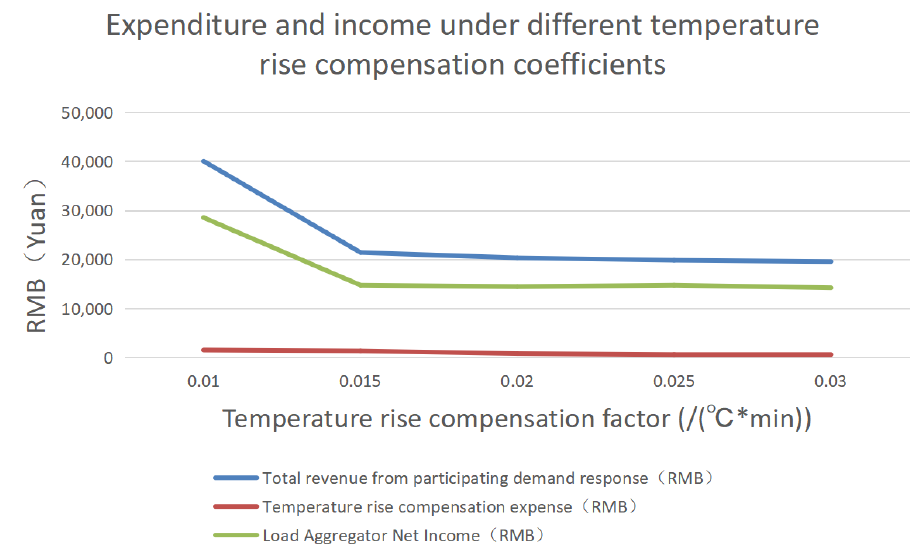
Figure 9. Expenditure and income under different temperature rise compensation coefficients.